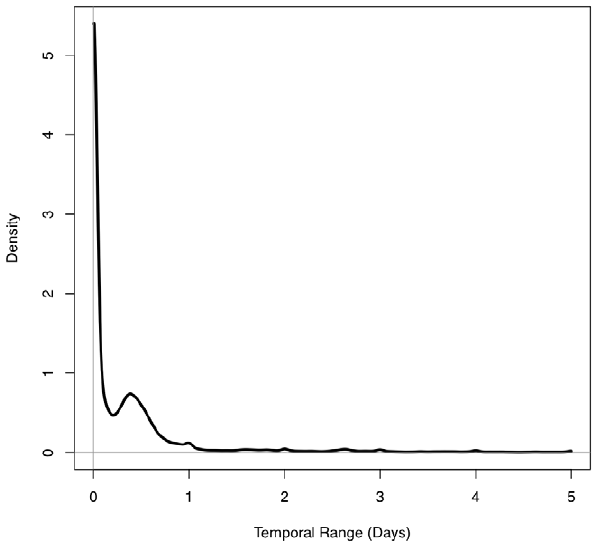
Figure 2. The distribution of temporal ranges within which burglaries and thefts are known to have occurred in Mesa, AZ for the period 2004–2009. Random draws from this distribution were used to offset the temporal coordinates of the original data.